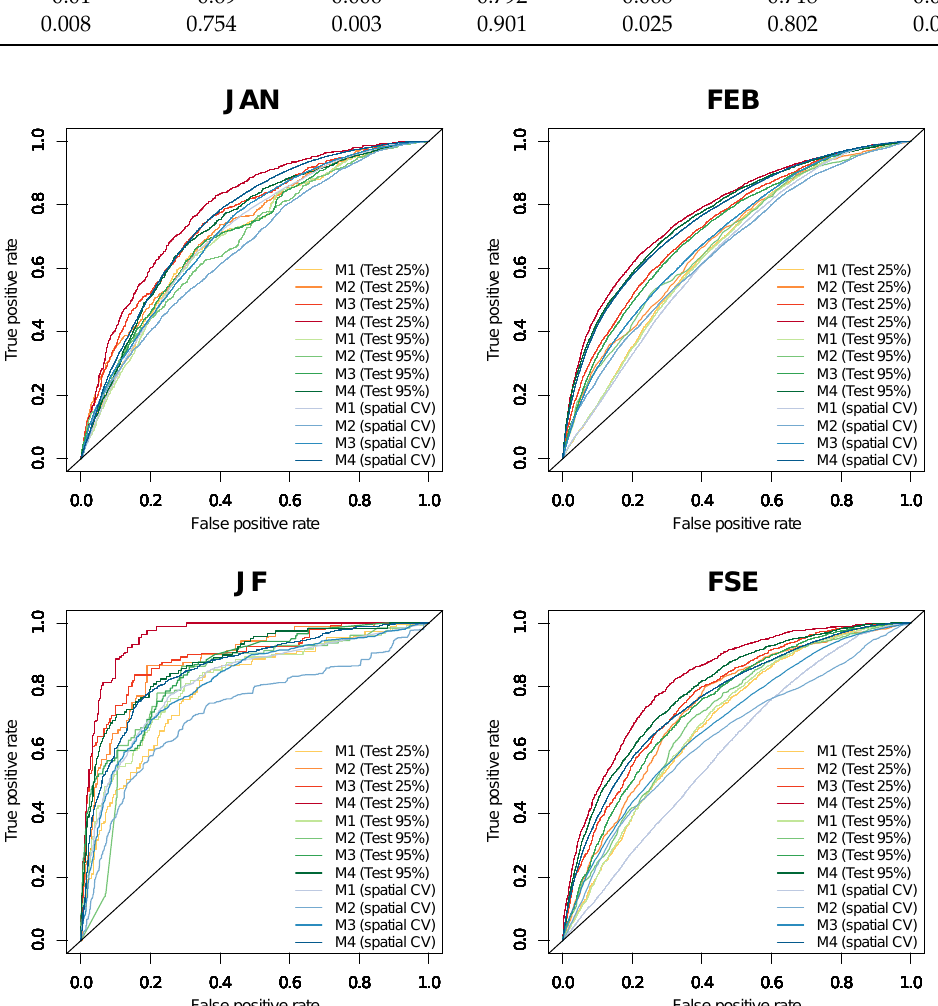
Figure 11. Average ROC curves: receiver operating box plots of the AUC values achieved by the M1, M2, M3 and M4 models, measured on the validation samples of the datasets JAN, FEB, JF and FSE for the validation Scenarios 1 (test rate 25%) and 2 (test rate: 95%).